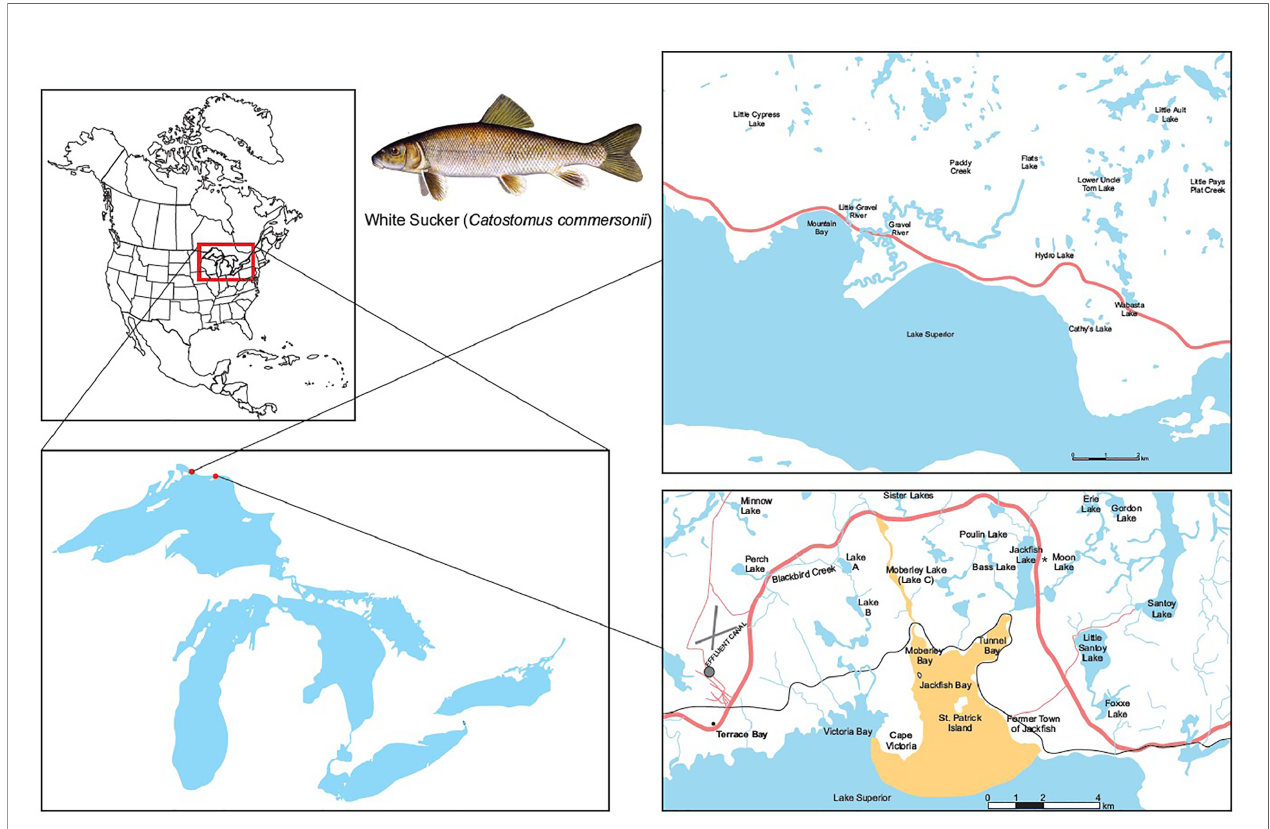
FIGURE 1 | Map of study site at Jack fi sh Bay on the north shore of Lake Superior, Canada. The Jack fi sh Bay area of concern in recovery includes Blackbird Creek, Moberley Bay, Tunnel Bay, and Jack fi sh Bay proper. Ef fl uent enters Blackbird Creek and fl ows into Lake Superior at Jack fi sh Bay (48°50 ′ N; 86°58 ′ W). Mountain Bay (46°56 ′ N; 87°58 ′ W) located 60 km away from Jack fi sh Bay was used as the reference site for the 30 year monitoring study. The * identi fi es the spawning site for Jack fi sh Bay white sucker at Sawmill Creek which is in the fl ow between Moon Lake and Jack fi sh